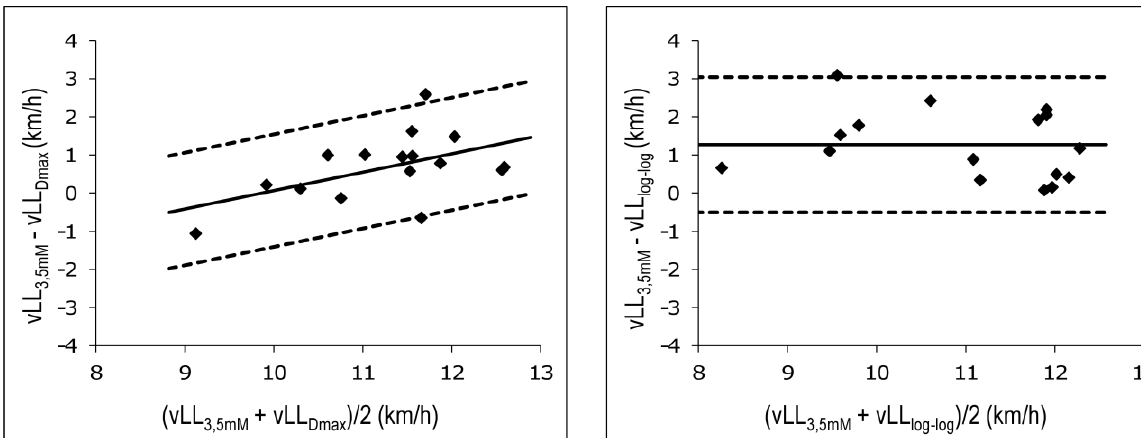
Figura 4 . Gráfico Bland-Altman: análise de concordância entre as velocidades de corrida no limiar de lactato determinadas pelos métodos da concentração fixa de lactato em 3,5 mM (vLL (esquerda) e vLL e log-log (vLL ) (direita). O viés (linha contínua) ±1,96 DP (linhas tracejadas) foi de 3,5mM log-log -4,75 + (0,48 × (vLL + vLL )/2) ±1,48 km/h (esquerda) e 1,27 ±1,77 km/h (direita) ( n = 3,5mM Dmax